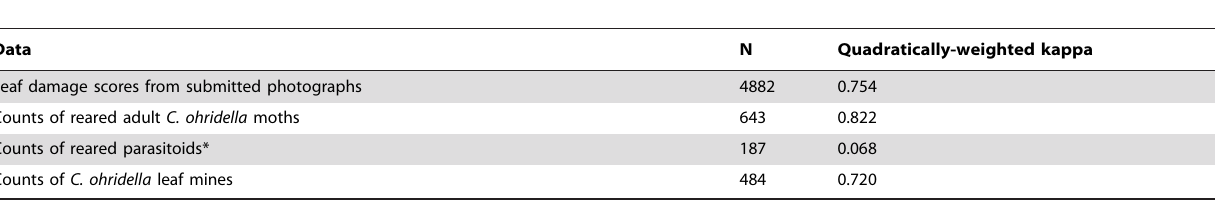
Table 1. Concordance (quadratically-weighted kappa) between the citizen science and expert-validated data based either on submitted photographs (leaf damage scores) or a retained subset of samples (all other